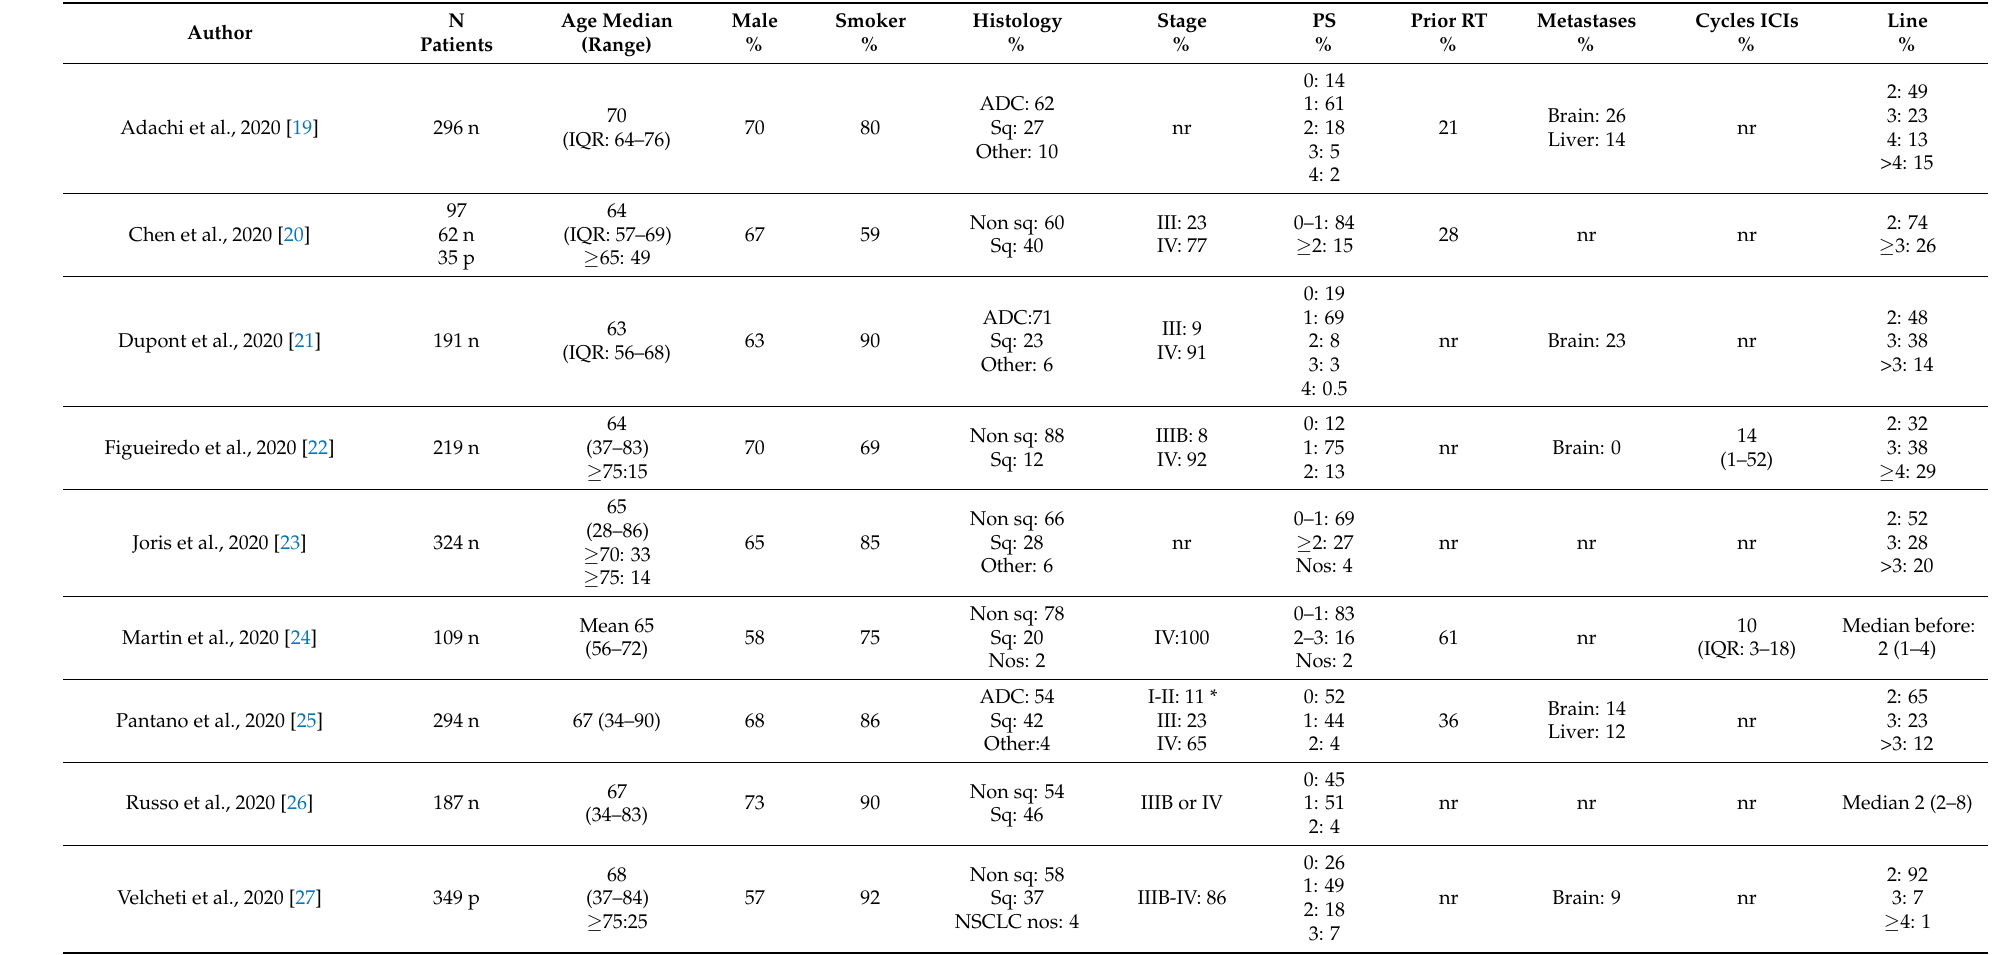
Table 1. Characteristics of the real-world studies enrolled in qualitative synthesis and